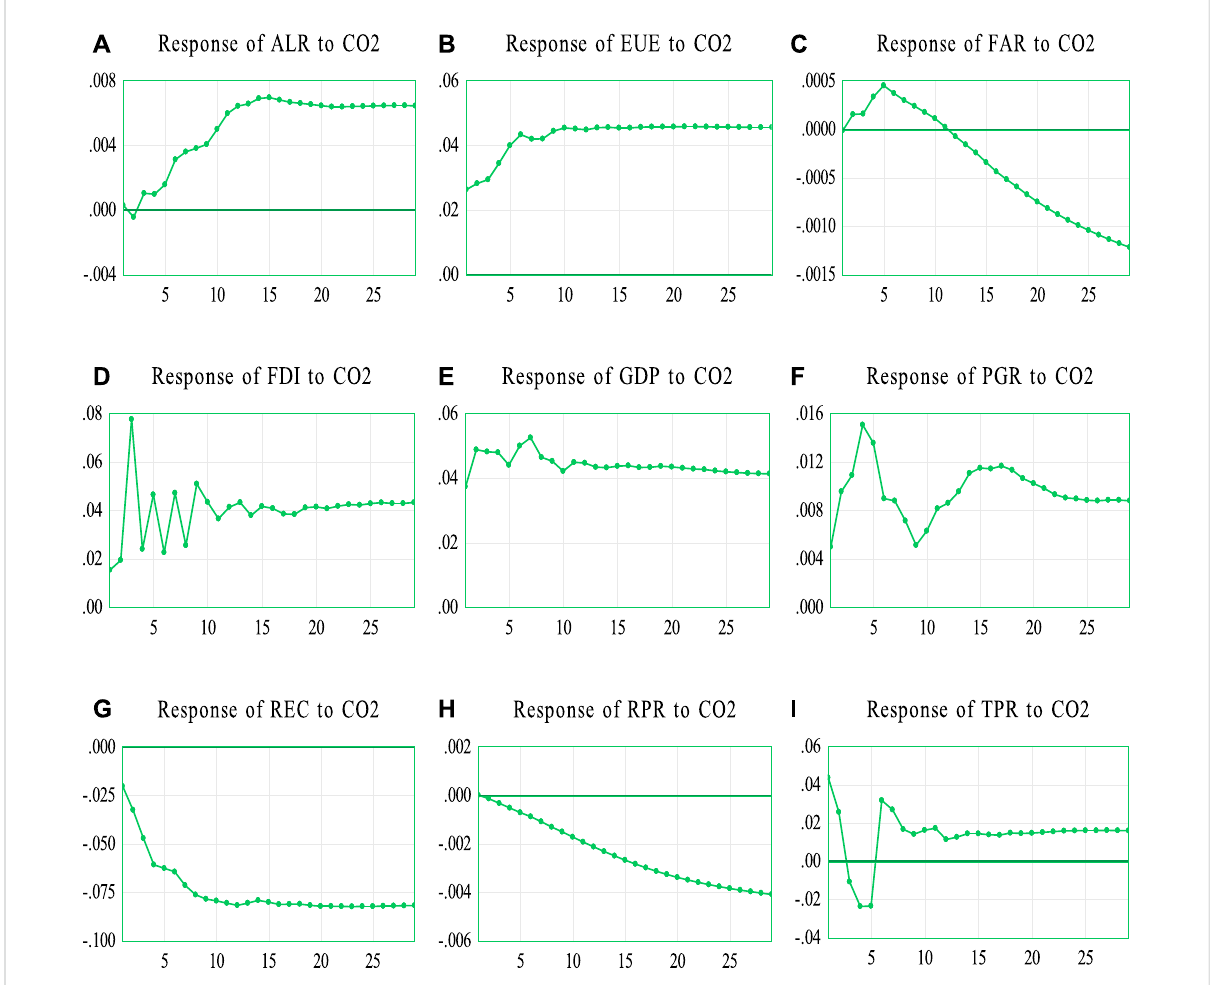
FIGURE 2 Impulse response to Cholesky one standard deviation (DOF adjusted) novelties. Notes: The horizontal axis of each impulse response function representsthesequenceorobservation oftimes,namely 1990=1,1991=2, 1992=3,andsoon.Theverticalaxisofeachimpulseresponsefunction expresses the impulse